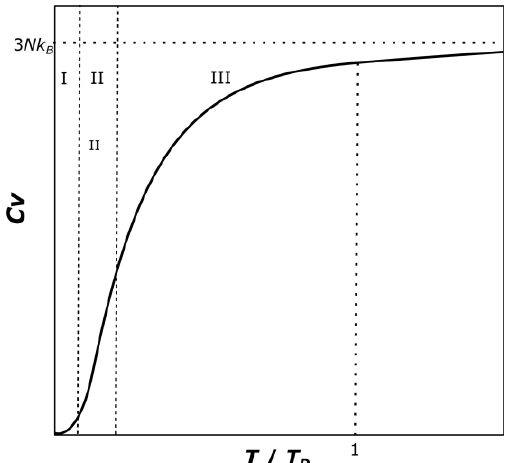
Figure 4. Qualitative curve of the Debye model, the three regions indicate the application of the different established conditions.